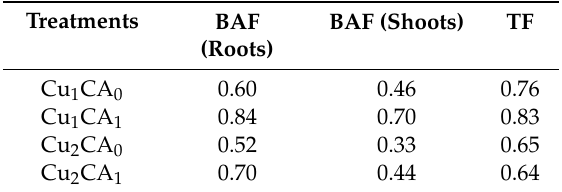
Table 2. Effect of citric acid (CA) application on bioaccumulation factor (BAF) and translocation factor (TF) of C. capsularis seedlings grown under different stress levels of Cu.